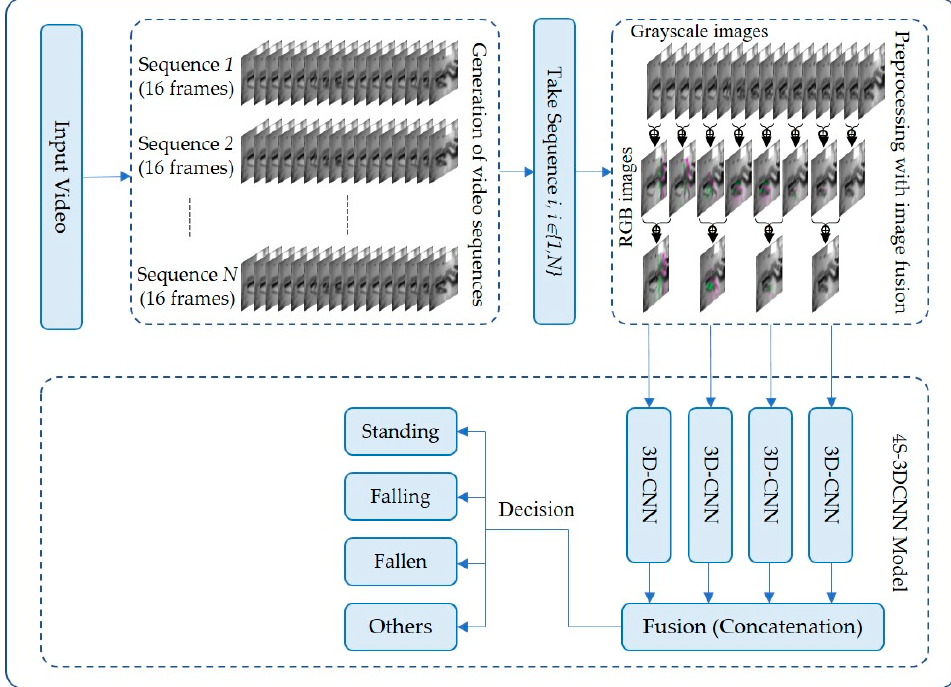
Figure 2. A simplified block diagram of the proposed fall detection system.